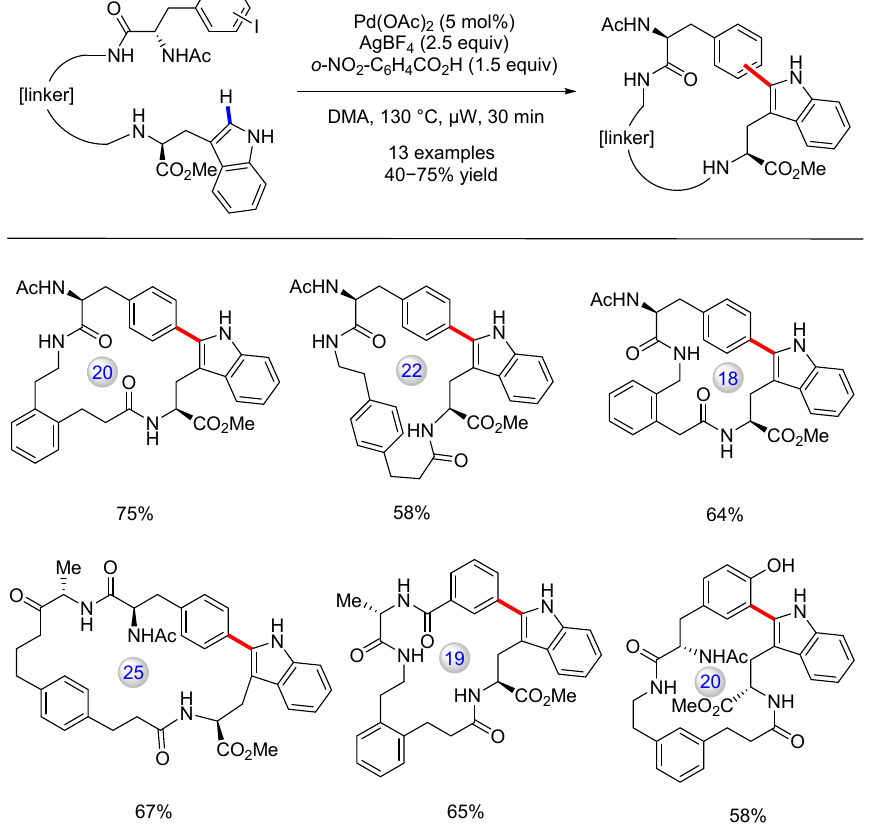
Figure 7. Synthesis of cyclic peptides via palladium-catalyzed intramolecular indole C-2 C–H bond arylation [64].